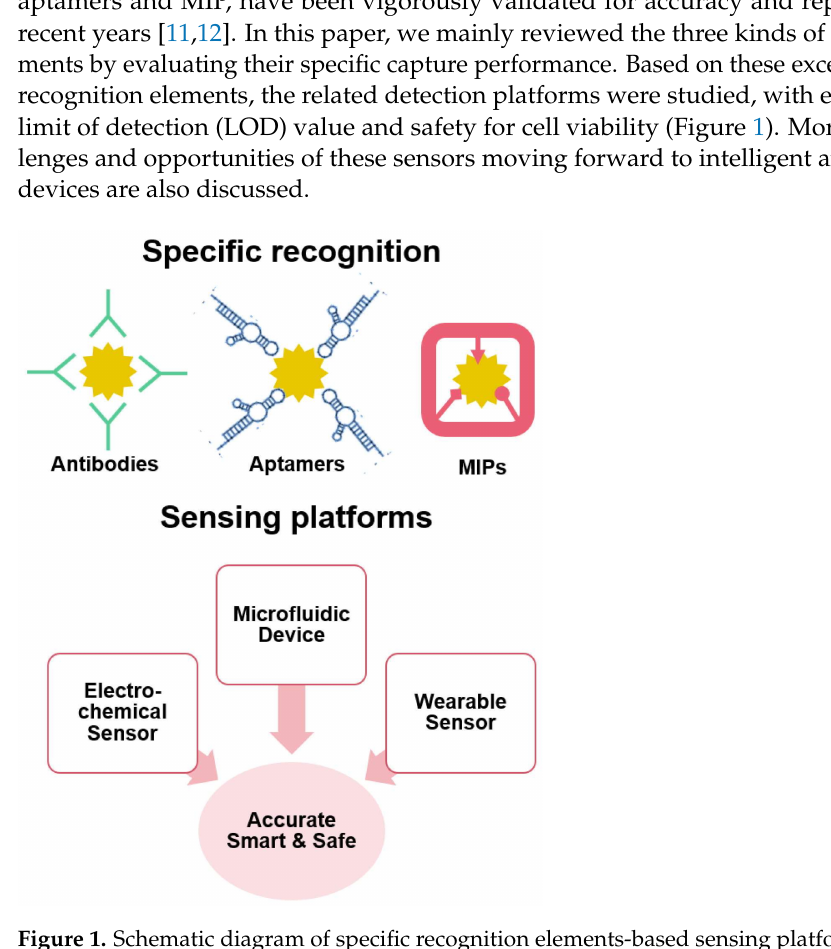
Figure 1. Schematic diagram of specific recognition elements-based sensing platforms for accurate, smart and safe capture and detection of